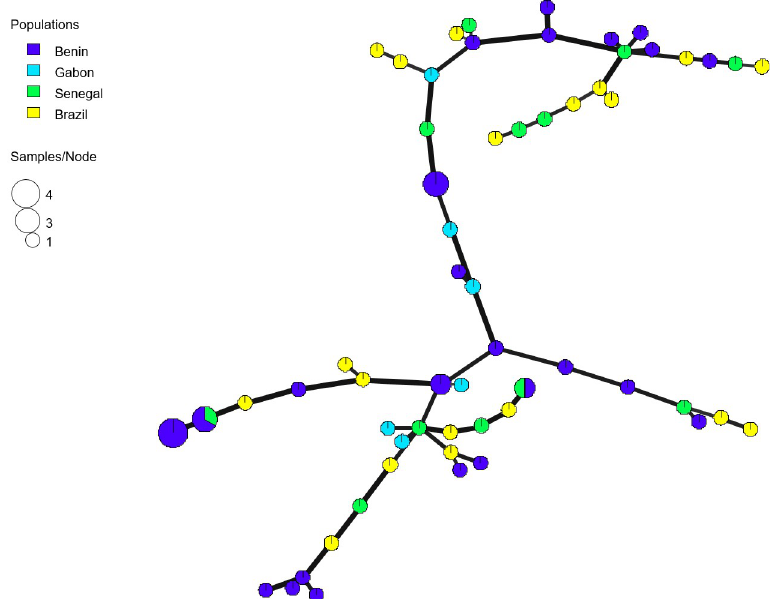
Fig 4. Minimum spanning network (MSN) showing the relationships between multilocus genotypes (MLGs) of Africa 1 lineage from Benin, Senegal, Gabon and Brazil. Thick and dark lines show MLGs that are more closely related to each other.